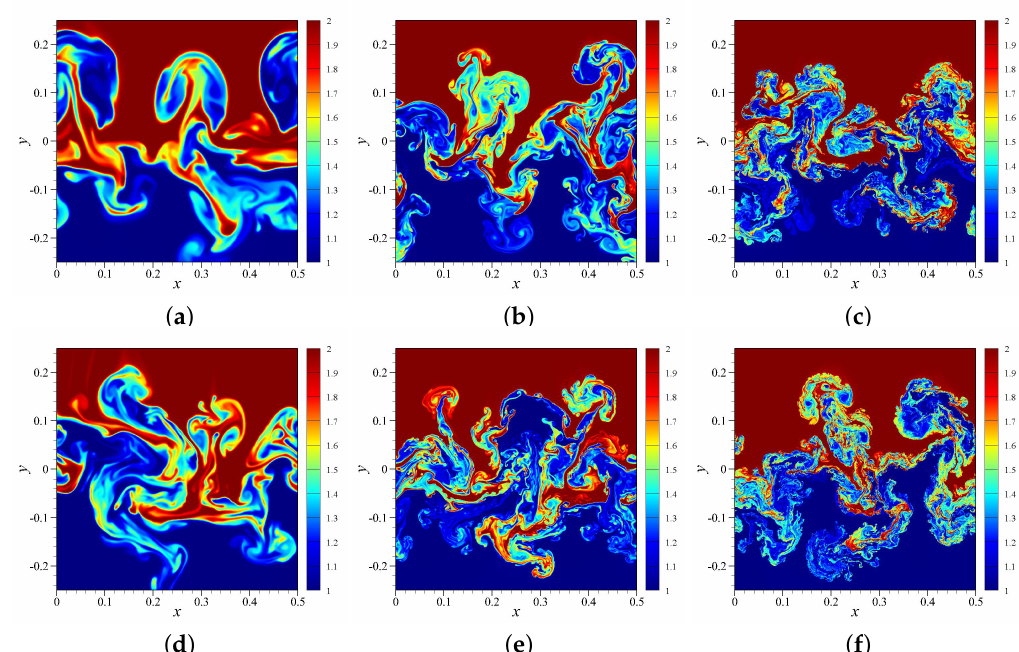
Figure 4. Density contours for the RTI problem with multi-mode perturbation at t = 4.0 for different coarse grid resolutions and ILES schemes: ( a ) ILES-Rusanov with 256 × 384 resolution; ( b ) ILES-Rusanov with 1024 × 1536 resolution; ( c ) ILES-Rusanov with 4096 × 6144 resolution; ( d ) ILES-Roe with 256 × 384 resolution; ( e ) ILES-Roe with 1024 × 1536 resolution; ( f ) ILES-Roe with 4096 × 6144 resolution. The gravity is directed in a vertically downward direction.